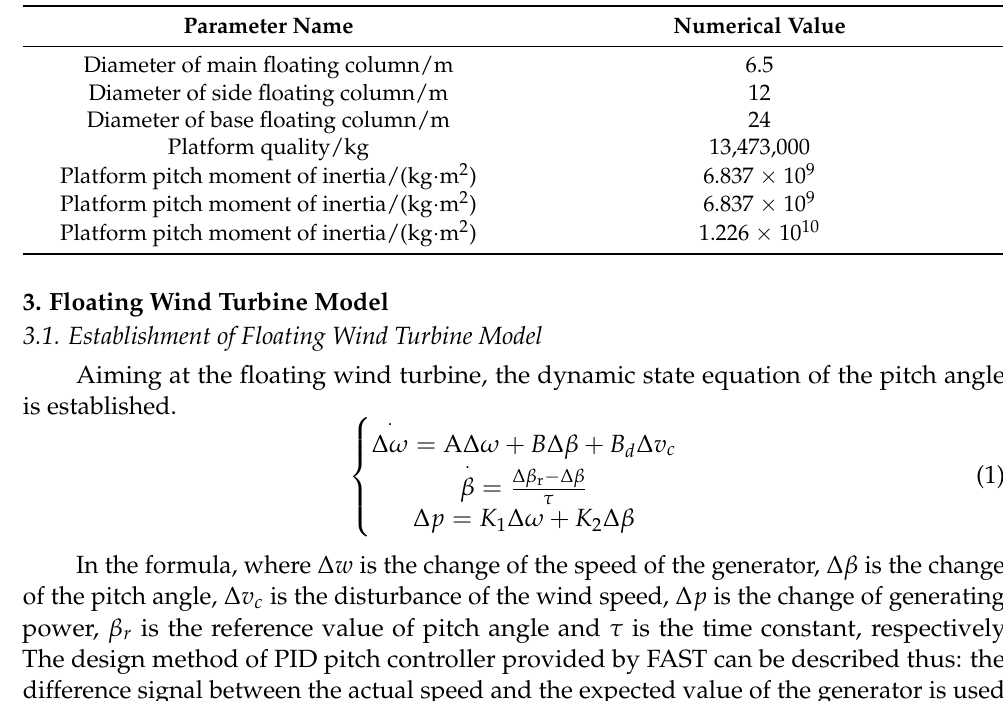
Table 2. Platform parameters of floating wind